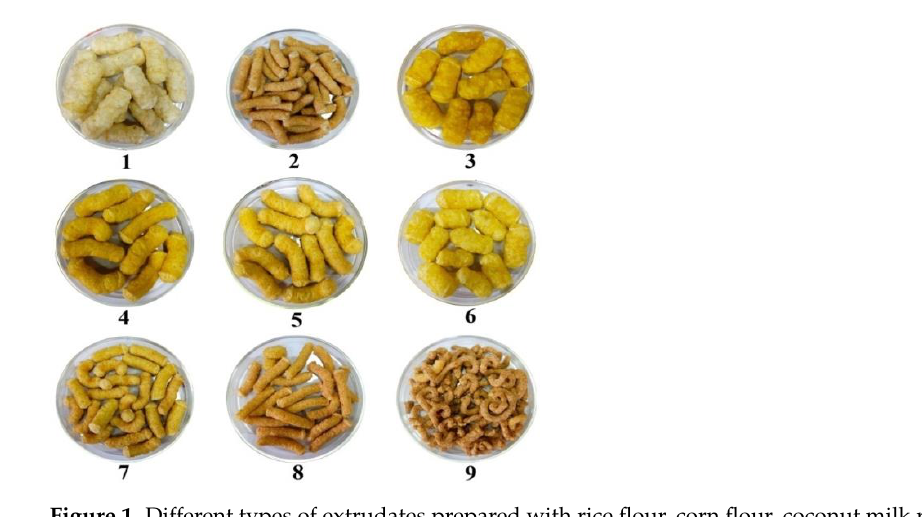
Figure 1. Different types of extrudates prepared with rice flour, corn flour, coconut milk residue and neera honey ( 1 ) 100% RF + 16% FM (water), ( 2 ) 100% RF + 16% FM (NH), ( 3 ) 100% CF + 16% FM (water), ( 4 ) 100% CF +16% FM (NH), ( 5 ) 50% RF + 50% CF + 16% FM (NH), ( 6 ) 50% RF + 50% CF + 16% FM (water), ( 7 ) 60% RF + 25% CF + 15% CMR + 16% FM (NH), ( 8 ) 100% RF + 20% FM (NH), ( 9 ) 85% RF + 15% CMR + 20% FM (NH).